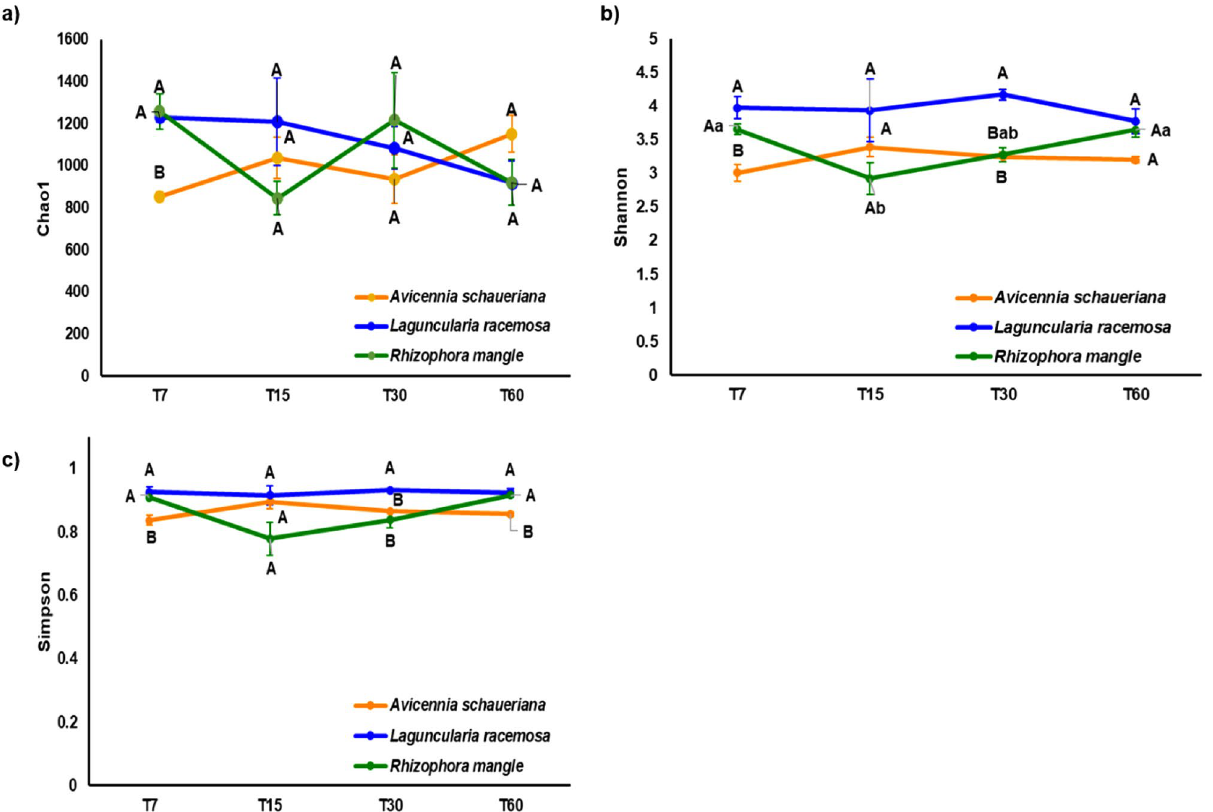
Figure 1. ( a ) Chao Index of richness. ( b ) Shannon and ( c ) Simpson alpha diversity indexes of the fungi community during the decomposition process of three plant species in Cananéia mangrove. Dots represent the average values of the sequenced replicates while error bars represent its standard deviation. Letters next to dots represent Tukey’s test results. Capital letters indicate differences between plants of the same time point while lower-case letters indicate differences between time points of the same plant. Omitted letters indicate that ANOVA test was not significant (p > 0.05).